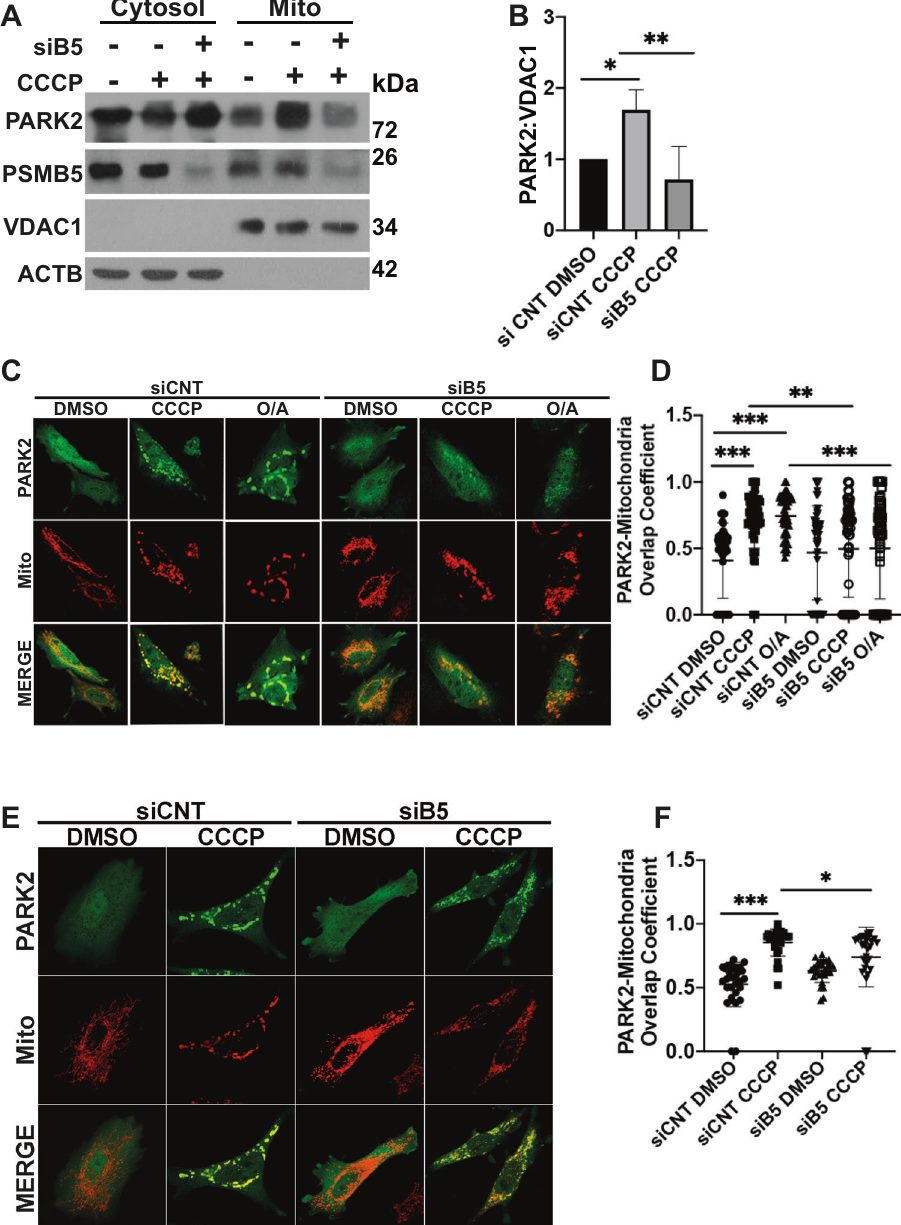
Fig. 5 20 S proteasome subunit PSMB5 and proteasomal activity are indispensable for PARK2 recruitment to mitochondria. A Representative western blot images showing PARK2, PSMB5, VDAC1 and actin beta (ACTB) protein levels in cytosolic (Cytosol) and mitochondrial (Mito) fractions of YFP-PARK2 expressing HEK 293 T cells transfected with control, non-targeting siRNAs (siCNT) or PSMB5- targeting siRNAs, (siB5) and treated with DMSO or CCCP (10 µM) for 12 h. B Quanti fi cation graph representing mitochondrial PARK2 levels normalized to VDAC1 from A (mean ± SEM, n = 3). C and E , Confocal microscopy analysis of YFP-PARK2 (green) and mito-dsRed (red) expressing and siCNT or siB5 transfected HeLa cells after 2 h ( C , DMSO, 20 µM CCCP or 10 µM O/A) and 12 h ( E , DMSO or 20 µM CCCP) of indicated treatments. MERGE, overlay of green and red signals. D and F Graphs showing quanti fi cations of overlap coef fi cient of PARK2 and mitochondria (mito-dsRed) from C and E respectively (mean ± S.D., n ≥ 30, one-way